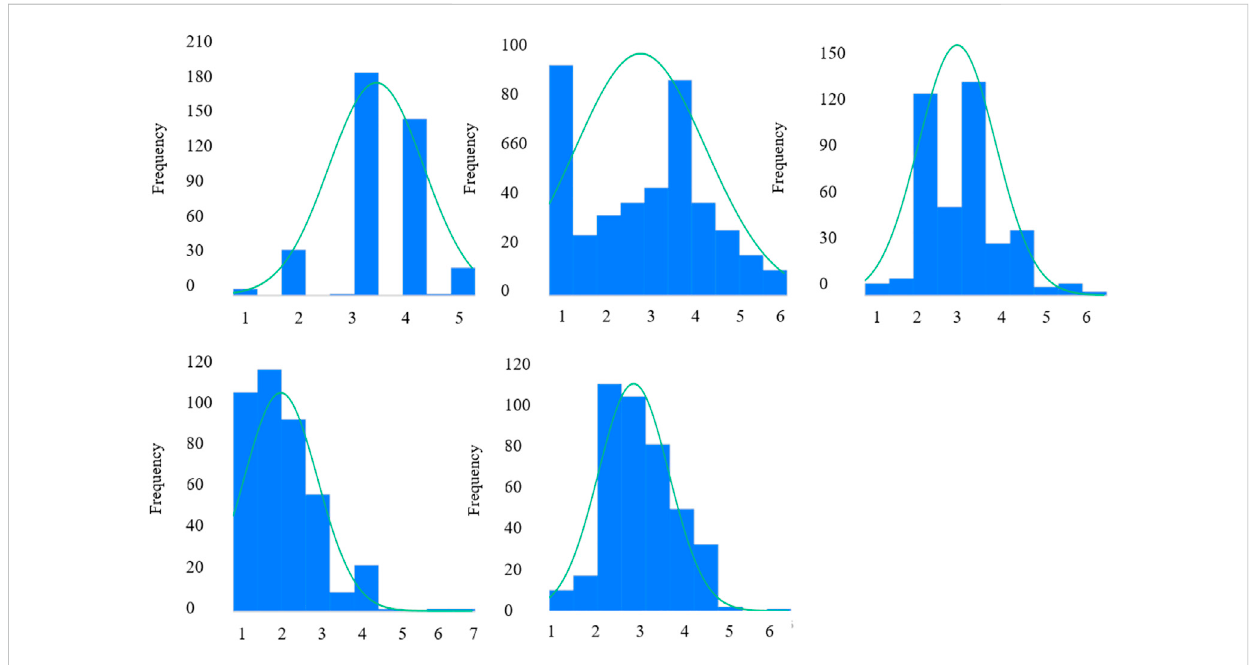
FIGURE 1 Normality test histograms for different regions.